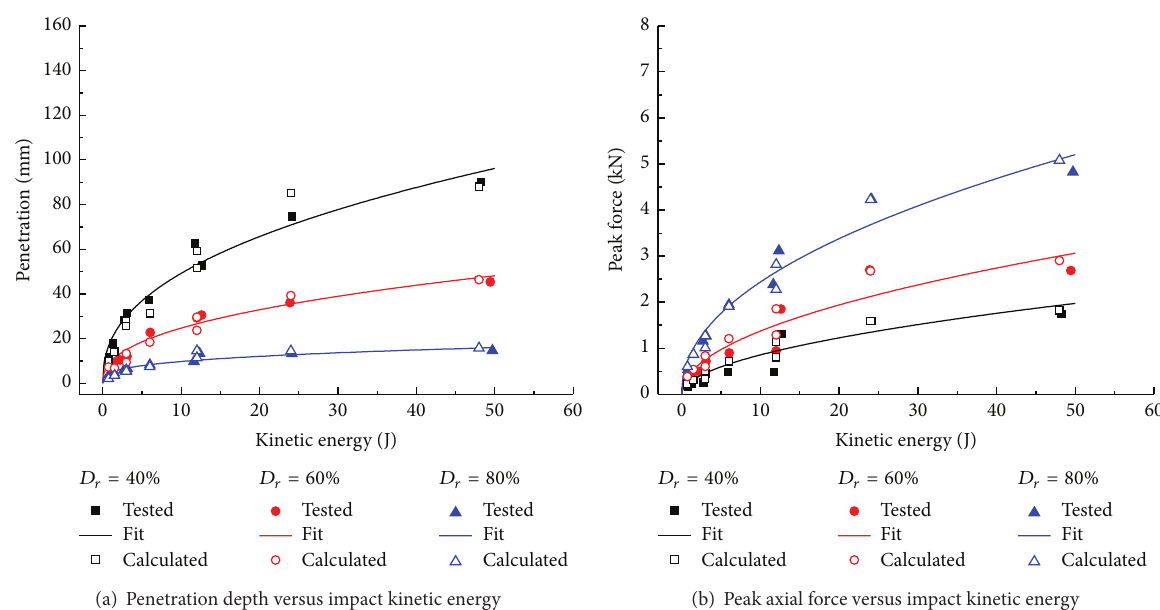
Figure 31: Comparison between calculated and tested